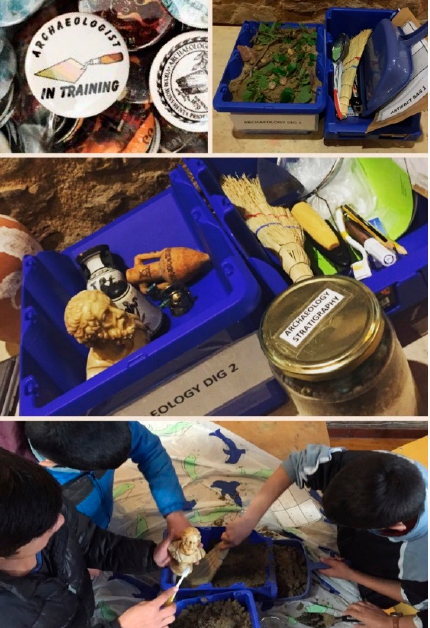
Figure 1. Sandbox dig. Photo by author.